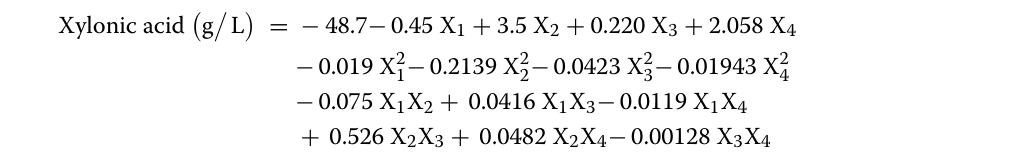
Table 2 Box–Behnken experimental design matrix with experimental values of xylonic acid production by Corynebacterium glutamicum ATCC 31831 Run order Urea (g/L) Xylose